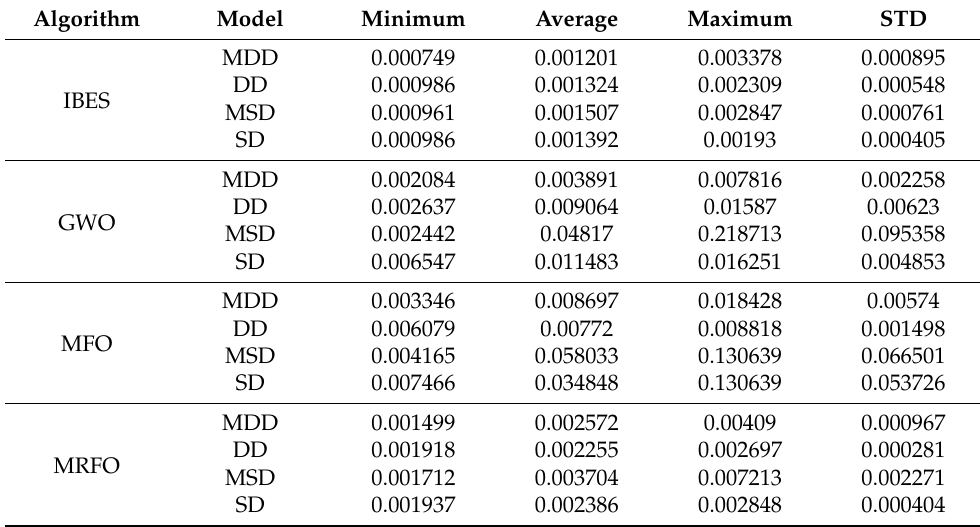
Figure 21. The convergence curves of the IBES, GWO, MFO, and MRFO applied to the MDDM, DDM, MSDM, and SDM. Table 9. Statistical results for the IBES, GWO, MFO, and MRFO applied to the MDDM, DDM, MSDM, and SDM.